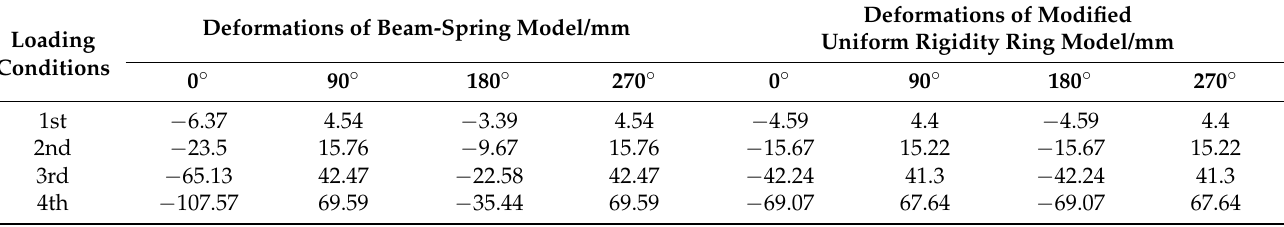
Table 7. Simulated deformations under different loading conditions (unit: